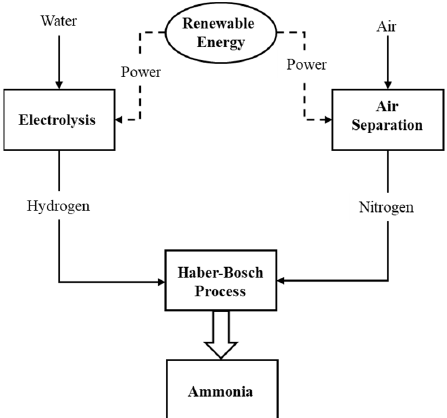
Figure 4. Green ammonia production process using green hydrogen + HB process.